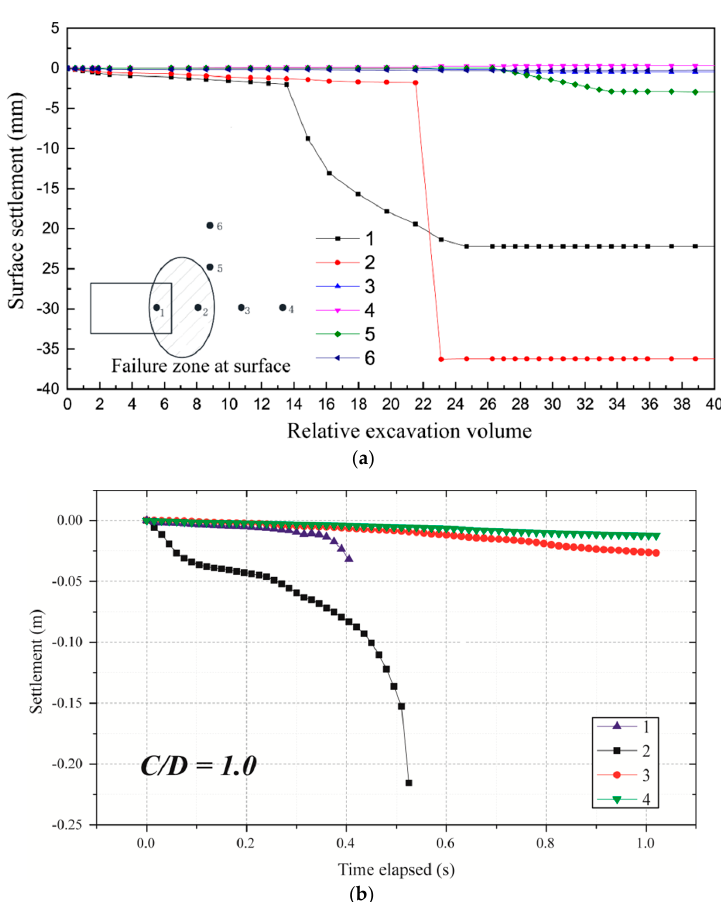
Figure 15. Evolution of the surface settlement during tunnel face instability ( C / D = 1.0): ( a ) results of the 1 g model test [36]; and ( b ) results of discrete element method (DEM) simulation.